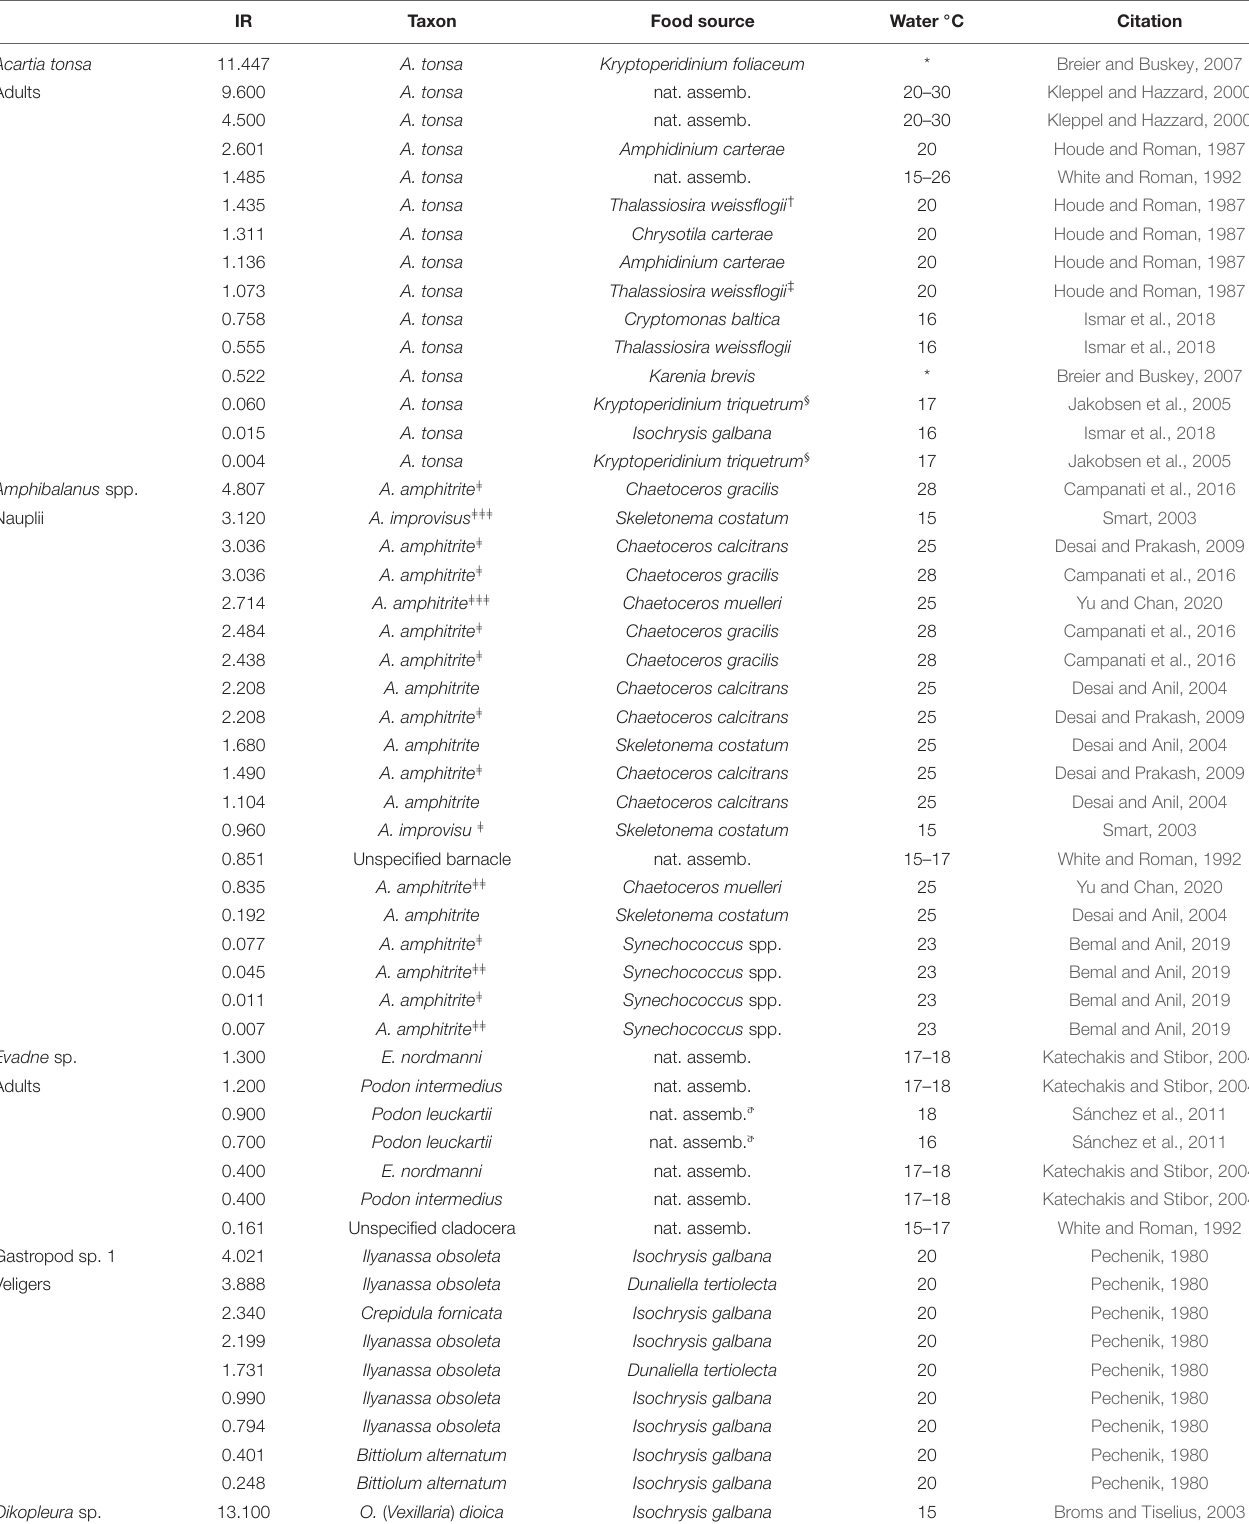
TABLE 3 | Ingestion rates (IR, µ g C ind − 1 d − 1 ) from studies of key grazers, or closely related taxa known to occur in the region, at the same or similar life stages, and examined at water temperatures within the range of this study. IR Taxon Food source Water ◦